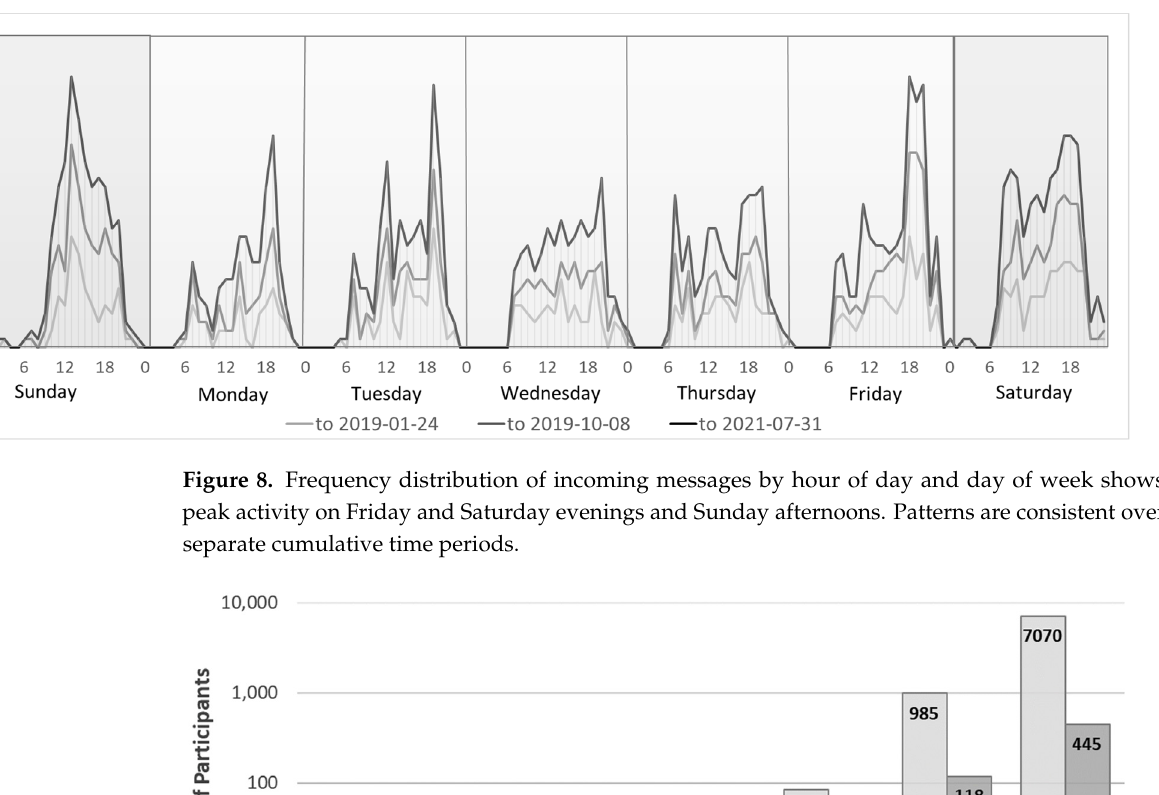
Figure 8. Frequency distribution of incoming messages by hour of day and day of week shows peak activity on Friday and Saturday evenings and Sunday afternoons. Patterns are consistent over sep- arate cumulative time periods.